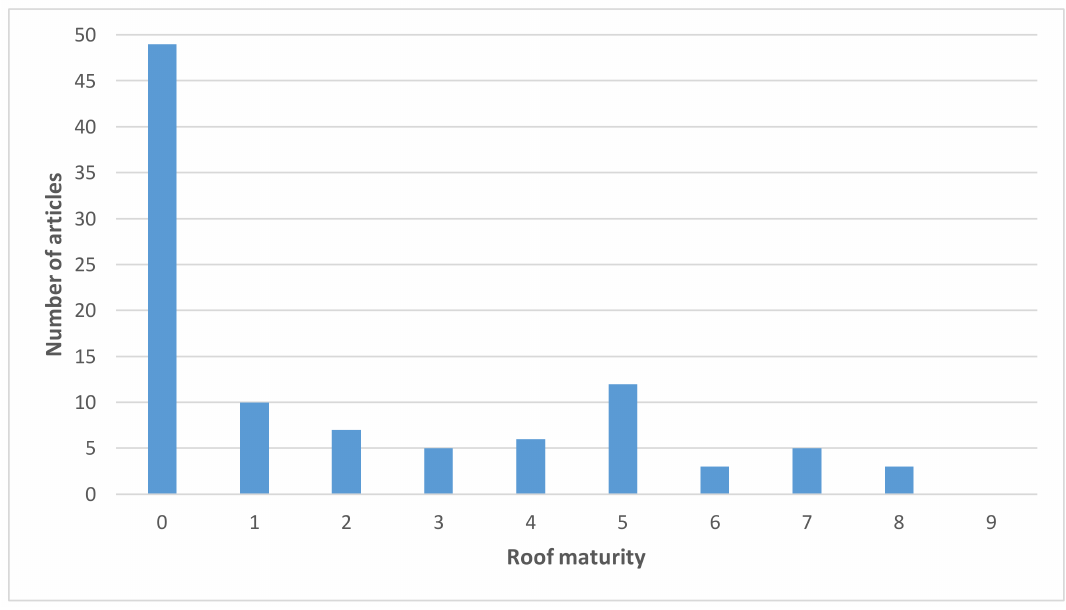
Figure 3. Number of articles by “maturity” of the roof assembly. The majority of investigated articles did not consider a specific roof assembly, hence the dominance of category 0. For a legend of the maturity categories, see Table